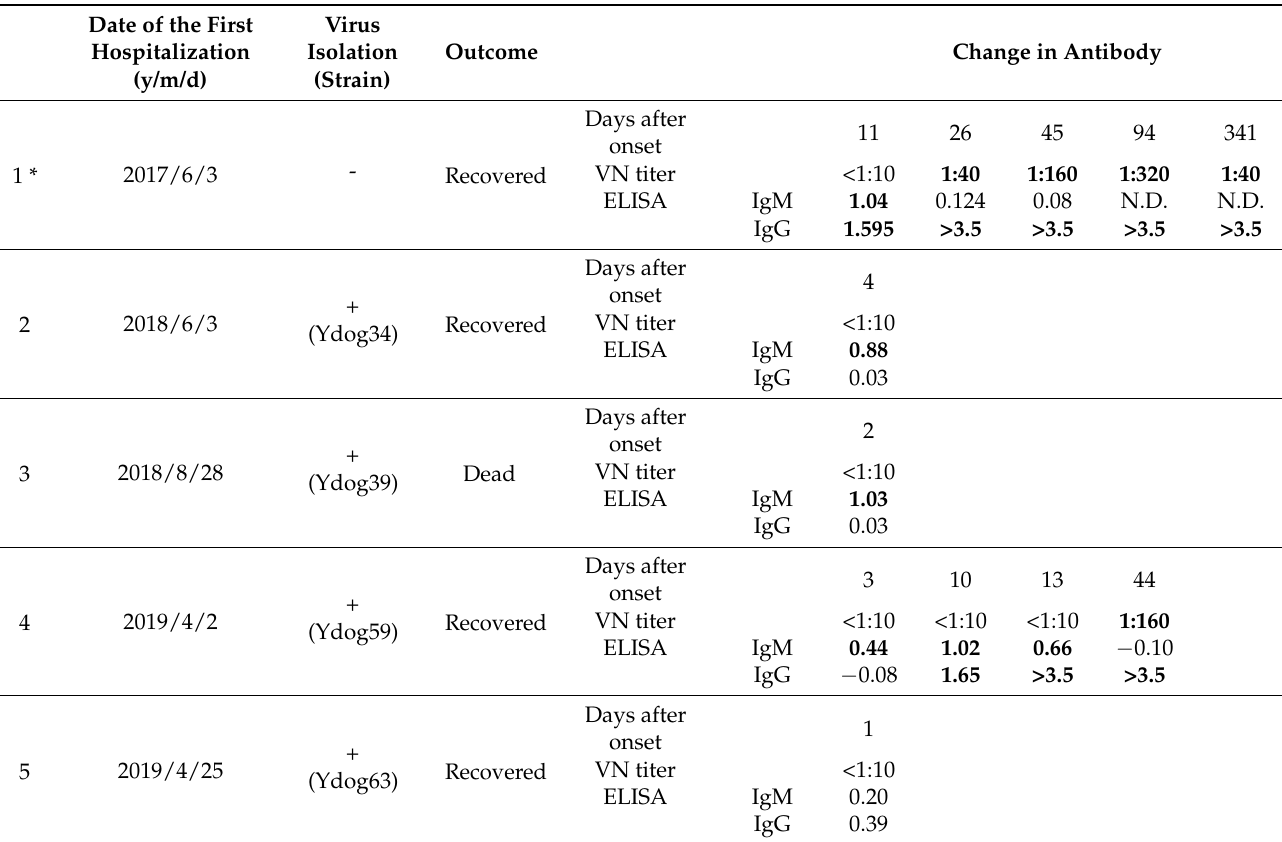
Figure 2. Changes in antibody titers of dogs with SFTS during observation. Lines indicate the OD values of the ELISA. Open and closed circles show IgG and IgM antibodies, respectively. Gray bars show VN titer by FRNT 50 .